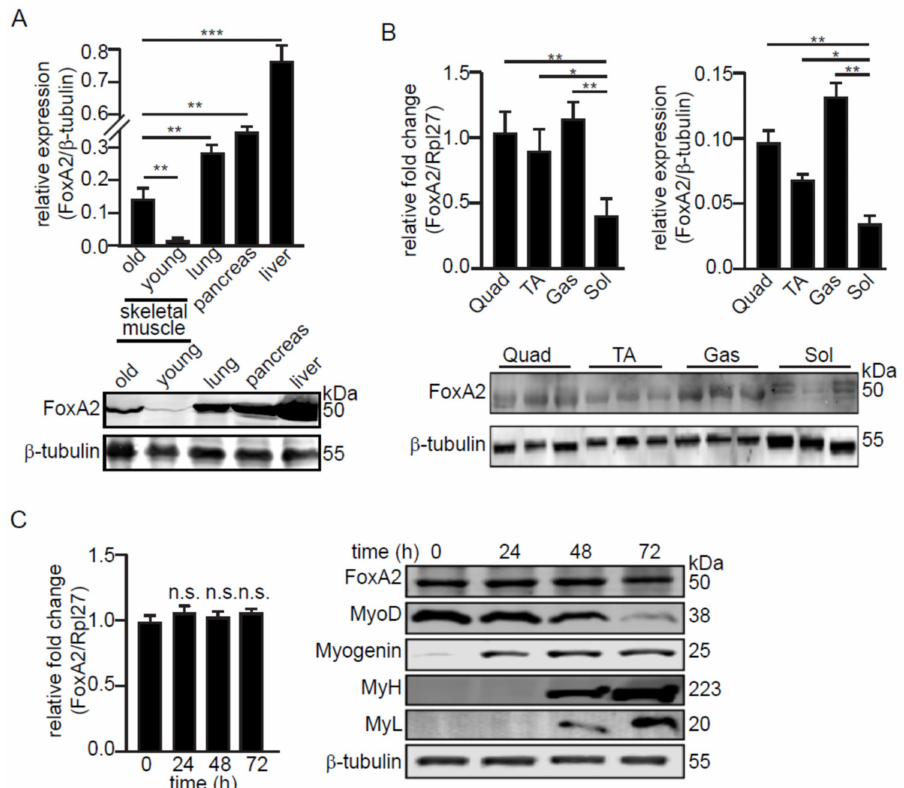
Figure 1. FoxA2 is expressed in C2C12 myoblasts and in skeletal muscle. ( A ) Relative FoxA2 expression in various mouse tissues; ( B ) in various hindlimb skeletal muscles; ( C ) and during myogenesis of C2C12 cells. Representative immunoblots of FoxA2, MyoD, myogenin, myosin heavy chain (MyH), and myosin light chain (MyL) are shown. β -tubulin serves as a loading control was from the same samples. Values are mean + SD from 3 independent experiments. * p < 0.05; ** p < 0.01; *** p < 0.0001; and n.s., not